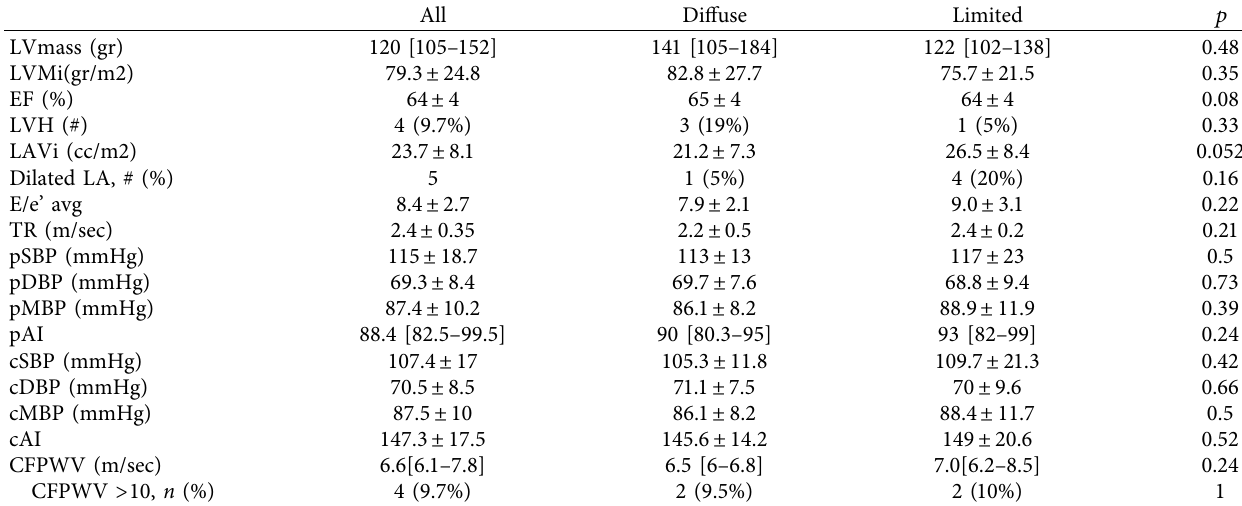
Table 2: Echocardiographic and hemodynamic parameters of SSc patients.